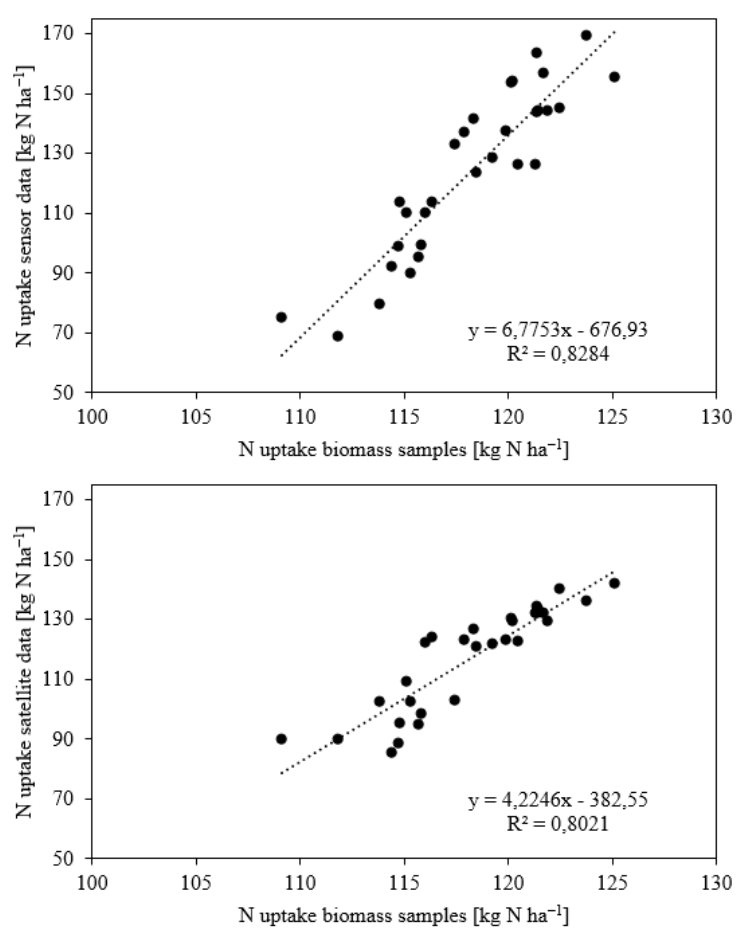
Figure 5. The linear relationships between nitrogen uptake of ground truth data and sensor data ( above ) and satellite data ( below ) in BBCH 39 in Field A in 2020.